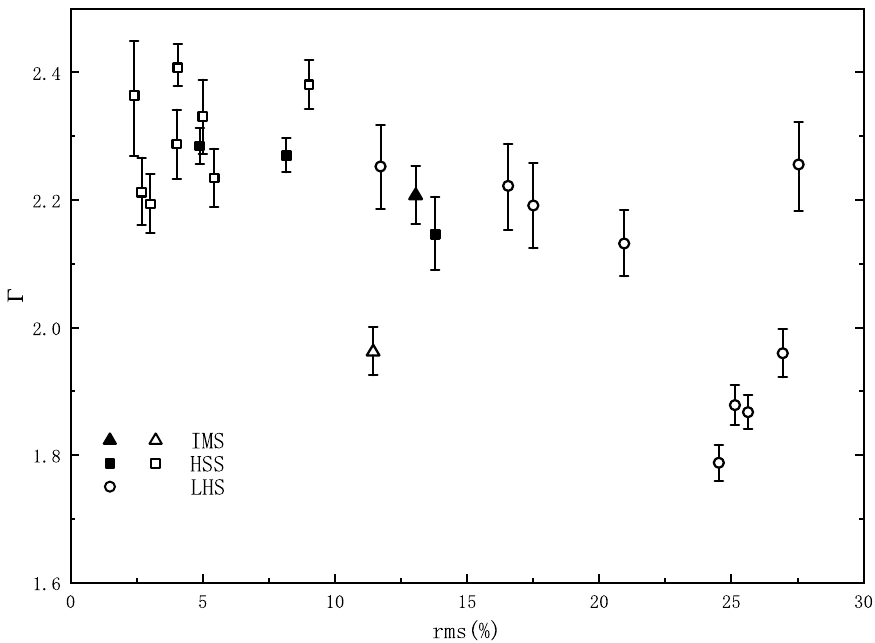
Figure 7. The relation between rms and Γ of H1743-322 during the 2005 outburst. The symbol types are the same as Figure